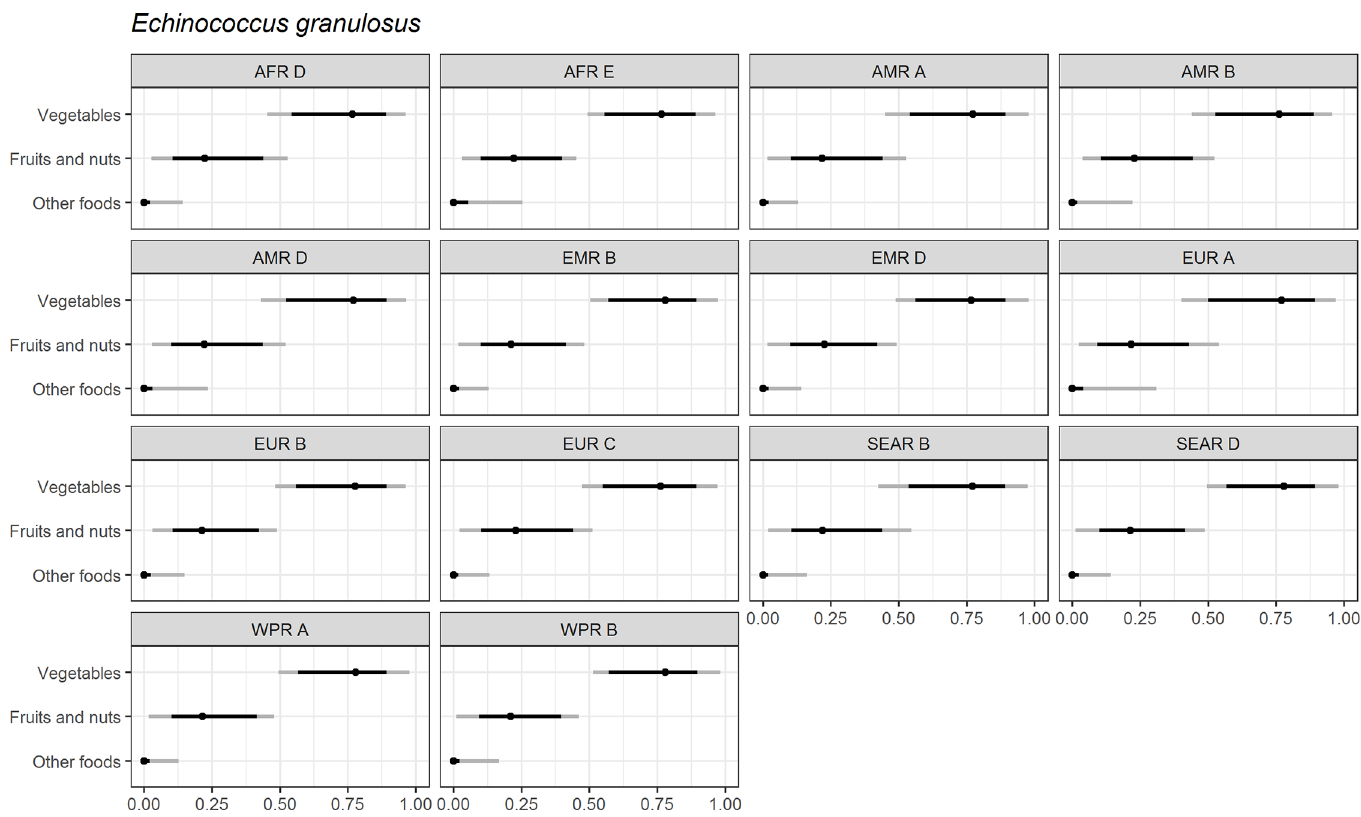
Fig 6. Echinococcus granulosus . Proportion of foodborne disease attributable to specific foods: Median estimate, and 90% and 95% uncertainty intervals by parasite and subregion. “Small ruminants’ meat” was listed as “Goat, lamb and other small ruminants’ meat” in the expert elicitation instrument. The X-axis labels are percentages. The dot represents the medianestimate; the dark black line, the 90% uncertainty interval; and the gray line the 95% uncertainty interval.